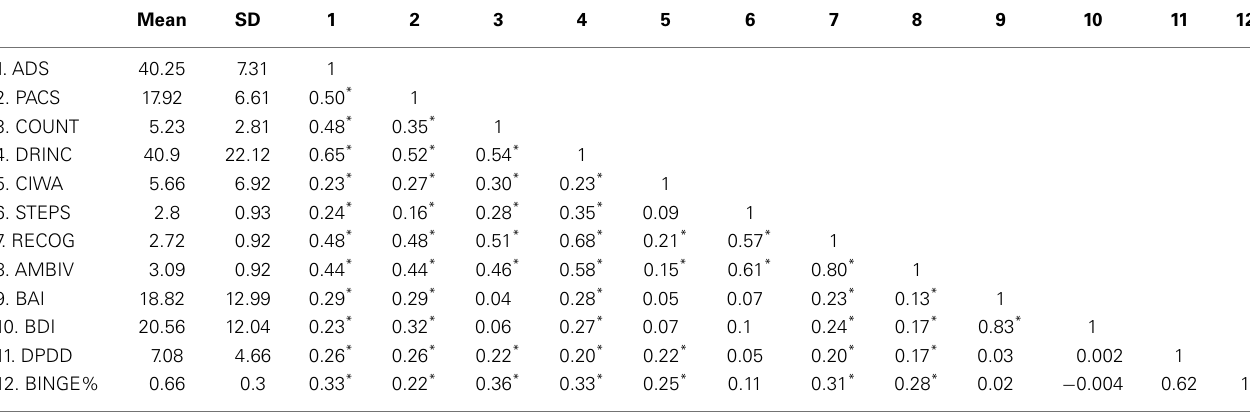
Table 1 | Means, standard deviation (SD), and correlations for all observed model parameters.